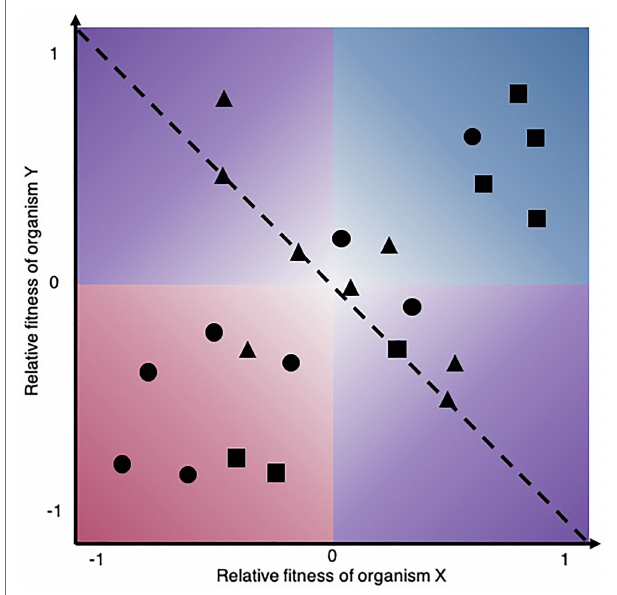
FIGURE 2 | Different microbial ecological interaction patterns may be revealed by distinct experimental approaches. Shapes in the biplot symbolize hypothetical microbial interactions mapped by different approaches among the same set of microorganisms that may reveal interactions mediated by contact-dependent mechanisms, diffusible compounds, or volatile compounds for instance. The dashed line partitions interactions where the net effect on community growth is positive (upper right) and negative (lower left), while they are neutral along the